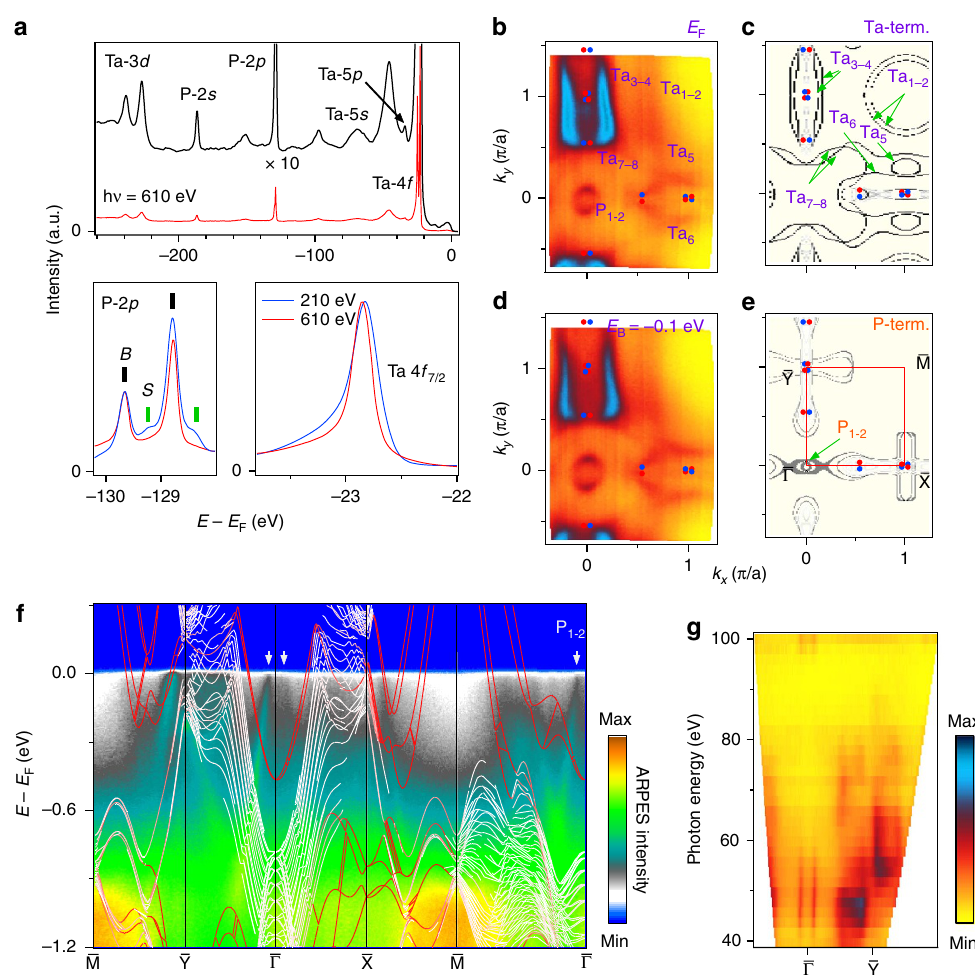
Figure 4 | Fermi arc on the Ta-terminated (001) surface of TaP. ( a ) Core level spectra taken with h n ¼ 610eV, and comparisons to the one recorded with vacuum ultraviolet light for P-2 p and Ta 4 f 7/2 core levels. ( b ) Fermi surface map recorded with vacuum ultraviolet light ( h n ¼ 50eV). ( c ) The calculated Fermi surface of the surface states on the Ta- terminated (001) surface. ( d ) ARPES intensity map at E B ¼ (cid:2) 0.1eV. ( e ) The calculated Fermi surface on P-termination (term.). ( f ) ARPES spectra along high symmetry lines acquired with h n ¼ 50eV. The calculated bands on Ta termination are overlaid for comparison. The surface bands resulting from the Ta-terminated surface are indicated with colour lines. The grey arrows indicate the surface states from P-terminated surface. ( g ) Photon-energy-dependent spectrum acquired with h n ¼